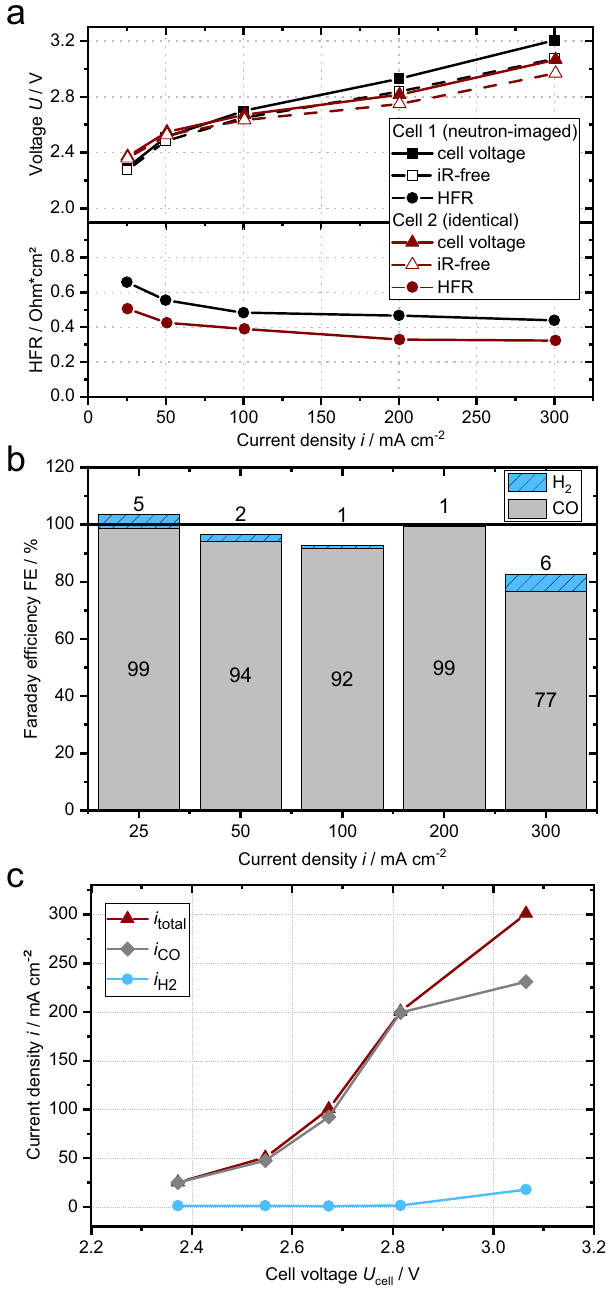
Fig. 2 | Electrochemical performance of the investigated CO 2 electrolysis cell. a cellvoltage,iR-freecellvoltageandhigh-frequencyresistance(HFR)overcurrent density. b Faraday ef fi ciencies of CO and H 2 of cell 2. c partial current densities of CO andH 2 (cell 2).The cellcomprised aSustainion® membrane, anIrO 2 anode and an Ag cathode (all purchased from Dioxide Materials ™ ). Measured at ambient temperature(23±3°C),withabubblerat50°Chumidifyingthecathodegasstream (47.5 sccm CO 2 and 2.5 sccm N 2 ) and 0.1 KOH anolyte circulated at 20mLmin − 1 . Source data are provided as a Source Data fi